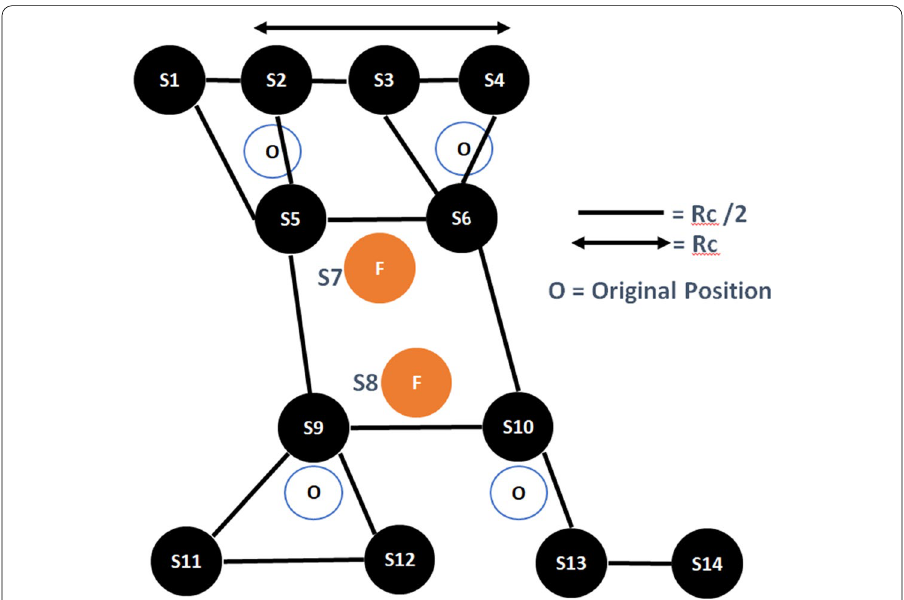
Fig. 6 Recovery of two cut-vertex